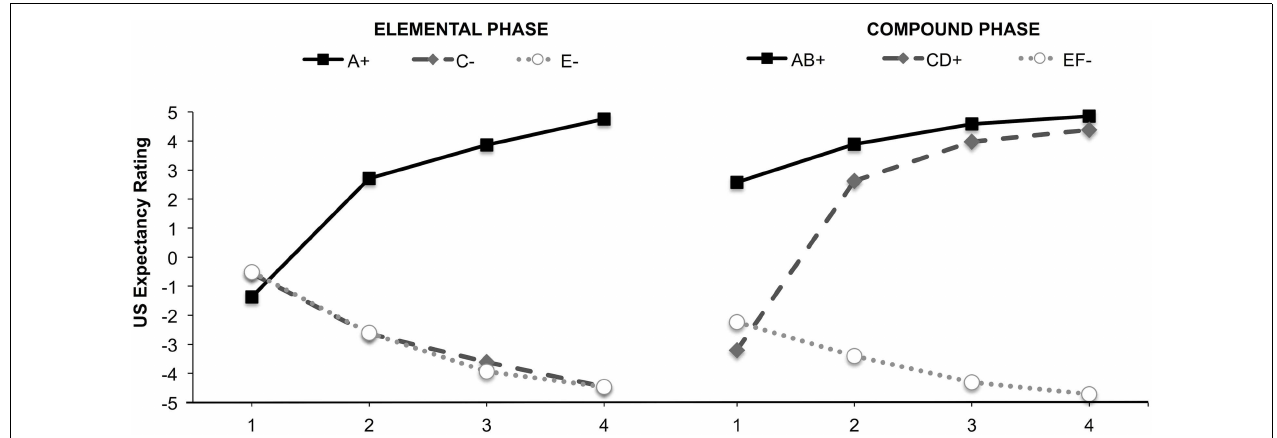
FIGURE 1 | US-expectancy rating during elemental (left panel) and compound conditioning (right panel)